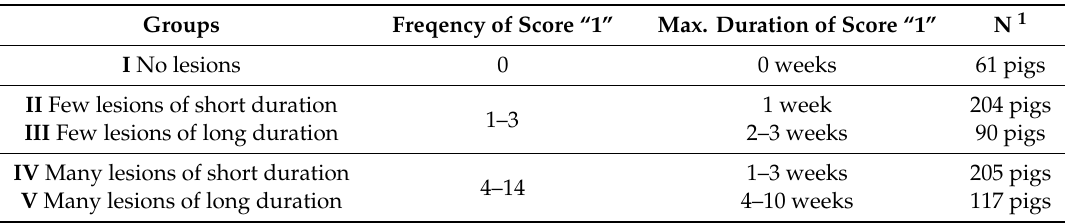
Table 2. Lesion groups (LG) built of the frequency of score “1” and the maximum duration of score “1”. Note that each pig was in one group only.